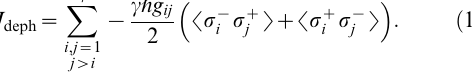
Fig. 1. The two different measures of efficiency, the energy and excitation transfer, exhibit very different behaviours when the dephasing parameter increases. The excitation transfer increases for small values of the dephasing ratio and decreases for higher ones. It is clear that the excitation transfer at the steady state can